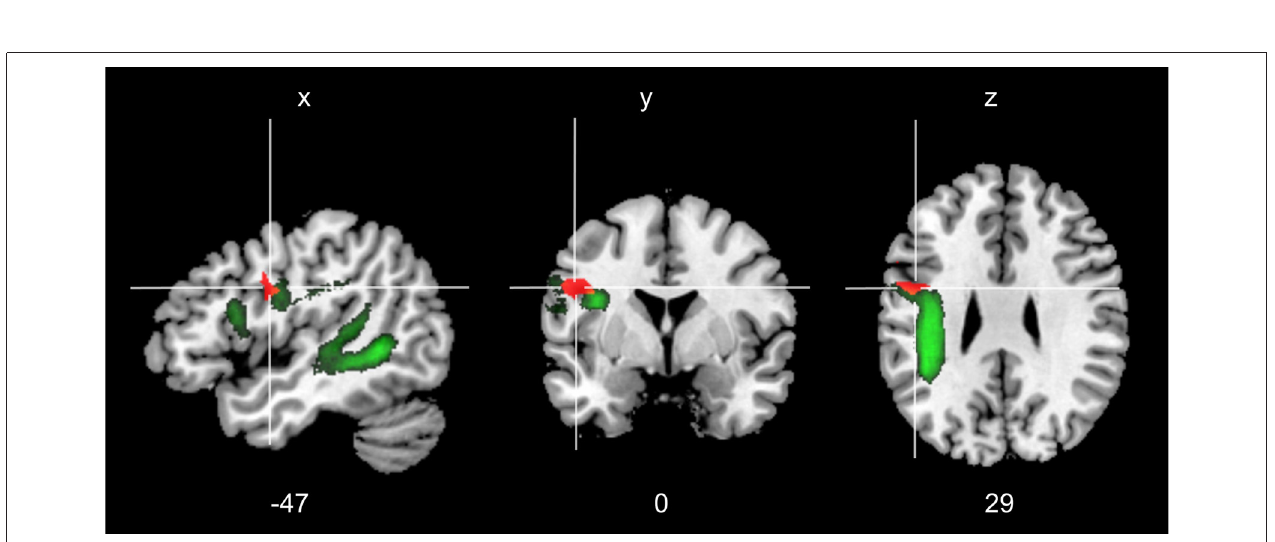
FIGURE 6 | Voxel-based lesion-symptom mapping (VLSM). Voxels depicted in orange represent brain damage locations that were significant predictors of an increased frequency of meaning-laden gestures per 100 words (FWE-corrected level at p < 0.05). The left arcuate fasciculus is represented in green, based on a recently published probabilistic DTI atlas (threshold > 50%, de Schotten et al., 2011). Talairach coordinates of the center of mass are presented at the bottom of the